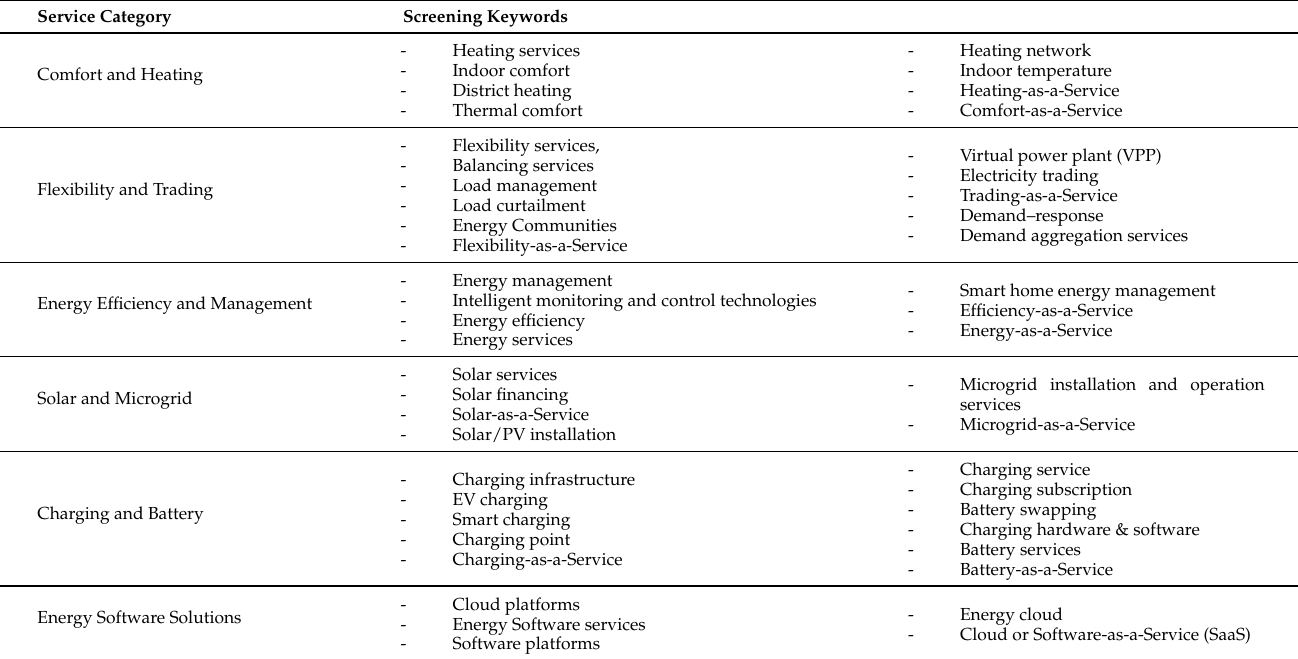
Table 2. Energy startup’s core category and service focus.